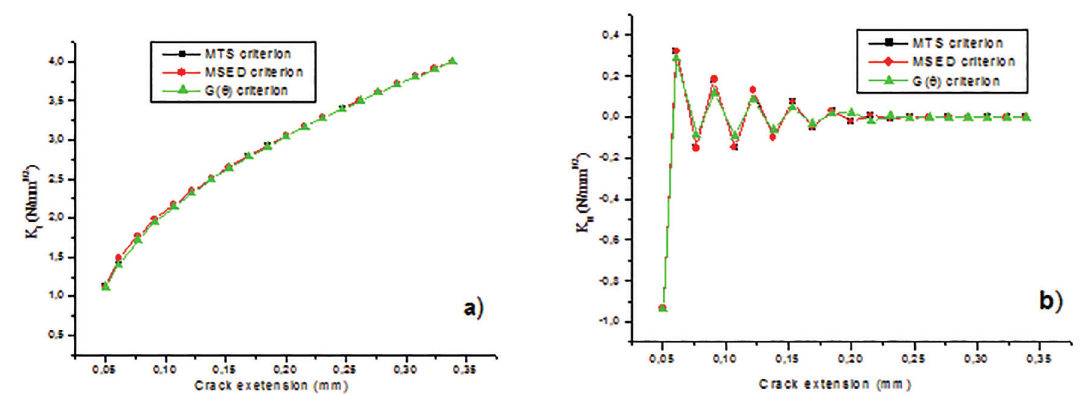
Figure 9: Variation of SIFs during crack extension for α =40°: a) K